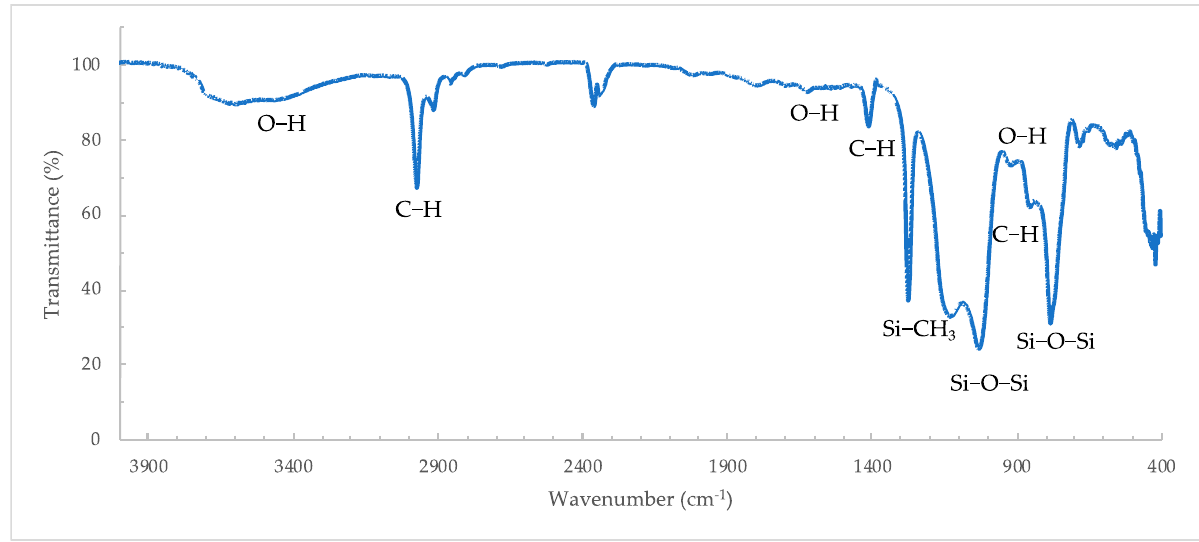
Figure 3. FTIR spectrum of the aerogel porous board.